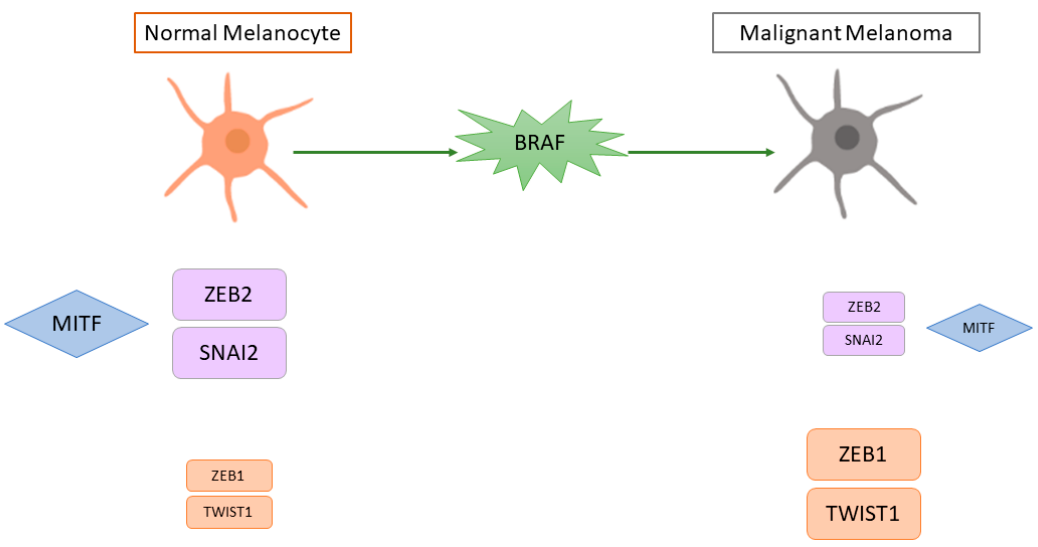
Figure 4. Schematic representation of the putative effect of BRAF mutation on pseudo-epithelial- mesenchymal transition and MITF in cutaneous melanoma. MITF = microphthalmia-associated transcription factor, SNAI2 = snail family transcriptional repressor 2, ZEB2 = zinc finger E-box binding homeobox 2, ZEB1 = zinc finger E-box binding homeobox 1, TWIST1 = twist family BHLH transcription factor 1, BRAF = B-Raf proto-oncogene, serine/threonine kinase. The size of the boxes represents the level of expression (higher expression = bigger box; lower expression = smaller box).